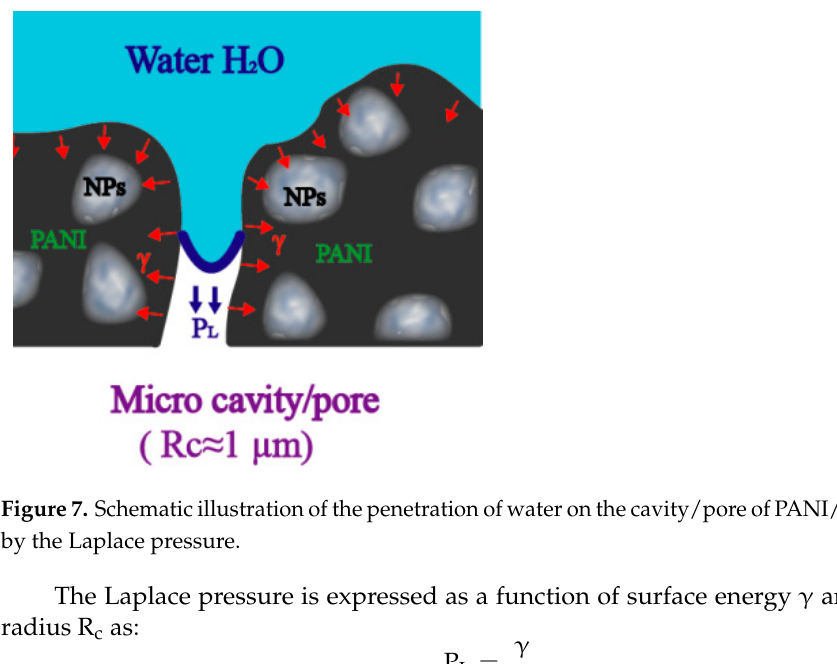
Figure 6. Work of adhesion of PANI/TiO 2 and PANI/ZnO as a function of the volume fraction Φ of NPs.